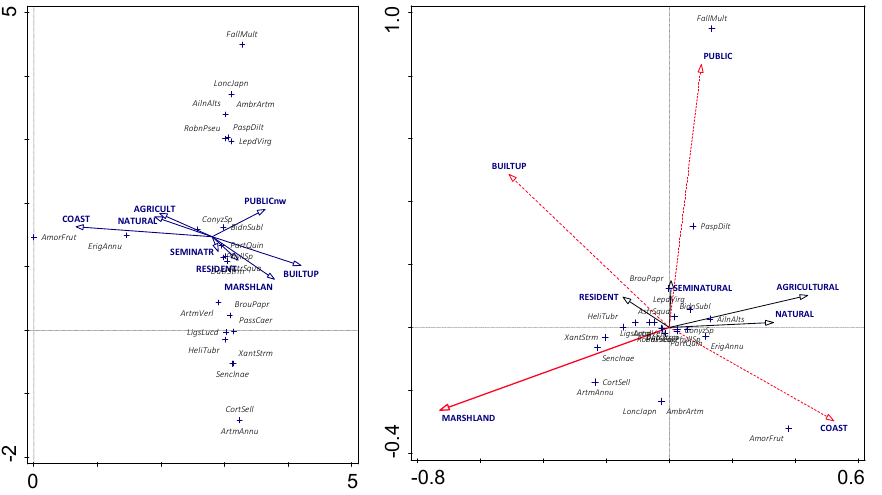
Figure 2. Taxa and factors (land-use), vectors passively projected into the ordination space ( left ). CCA analysis of taxa and factors; red—statistically significant vectors (factors): p (adjusted) < 0.05; red-dashed vectors (factors): p < 0.05, but p (adjusted) > 0.05; black solid vectors (factors)—statistically insignificant vectors (factors): p (adjusted) and p > 0.05 ( right ). Table 3. Forward selection results of the CCA analysis. Total variation is 4.66, explanatory variables account for 20.7% (adjusted explained variation is 10.8%).